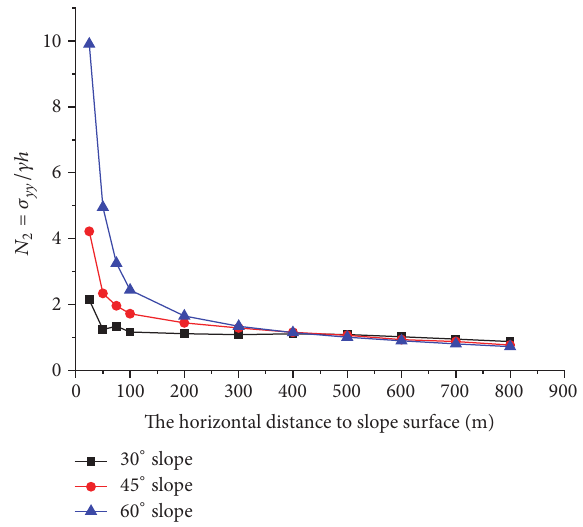
Figure 3: Variation curves of 𝑁 2 at the elevation of 0m in different slope angles only considering the gravity